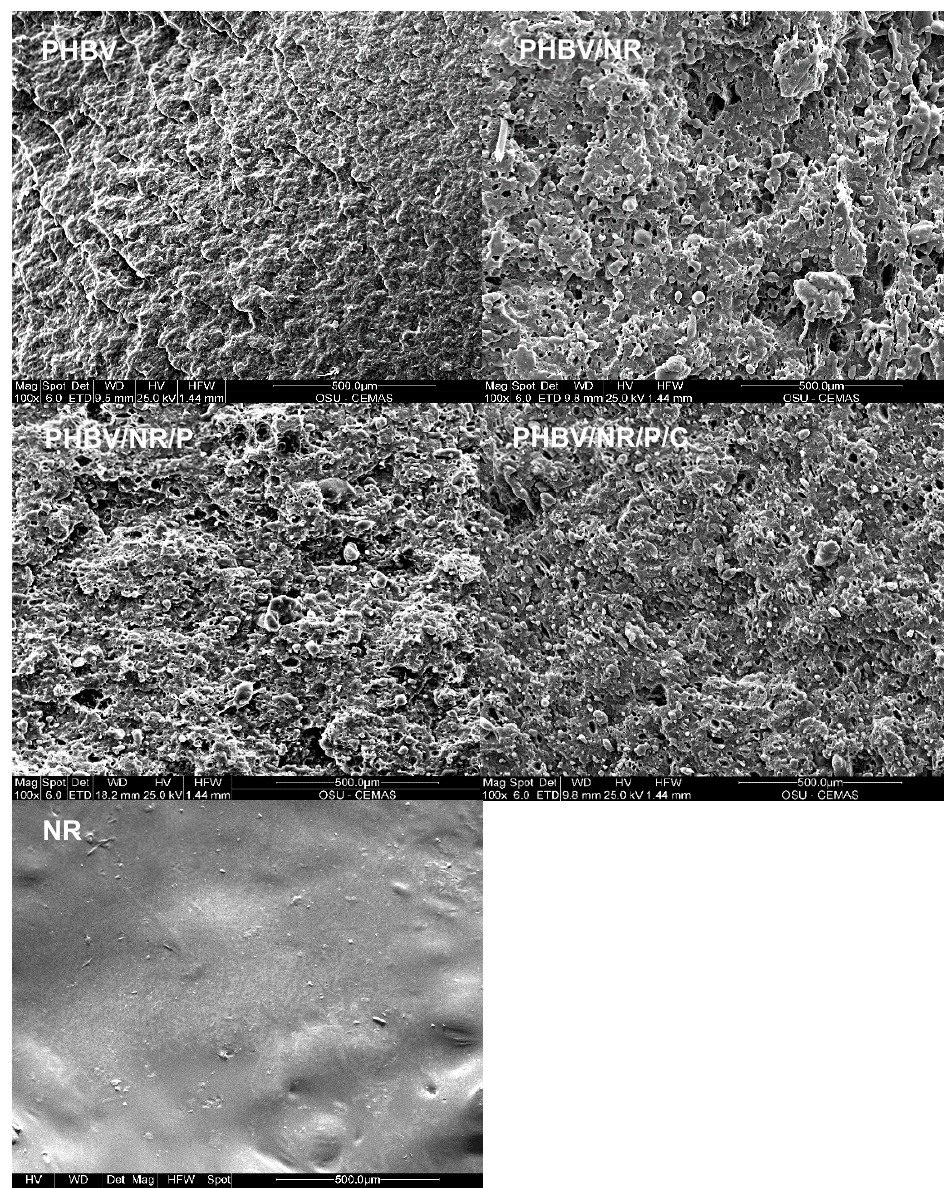
Figure 5. SEM images of the fracture surfaces of PHBV, NR, and the blends.